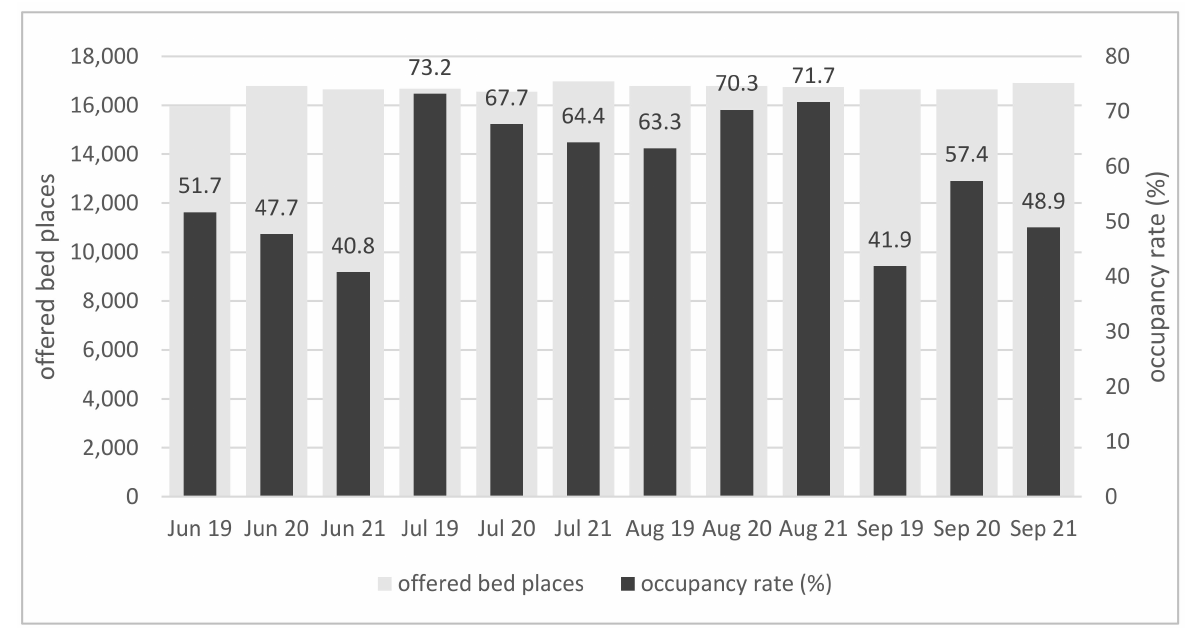
Figure 3. Offered bed places and occupancy rates in Binz, Southeast Rügen Biosphere Reserve, during the summers of 2019, 2020 and 2021 (data source: